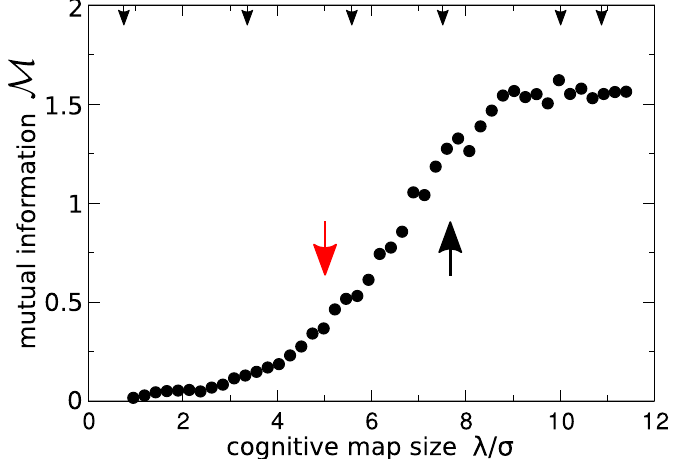
Figure 4. Mutual information as an order parameter in the transition of cognitive agents. As the size of the cognitive map λ increases, the mutual information  among the cognitive agents increases once their maps overlap significantly. The calculations of the mutual information  depending on λ were done for a system of size L = 80 σ at fixed number density. The results are averaged over eight independent simulations for each data point. The small arrows on the top abscissa axis indicate the values of λ for the configurations shown in Fig. 2, whereas the large black and red arrows mark the location of the systems considered in Fig.